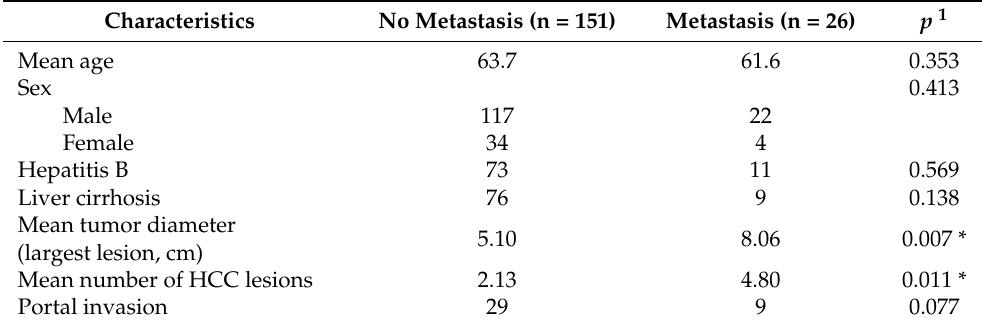
Table 3. Comparison of demographic information and clinical characteristics between metastatic and non-metastatic groups.